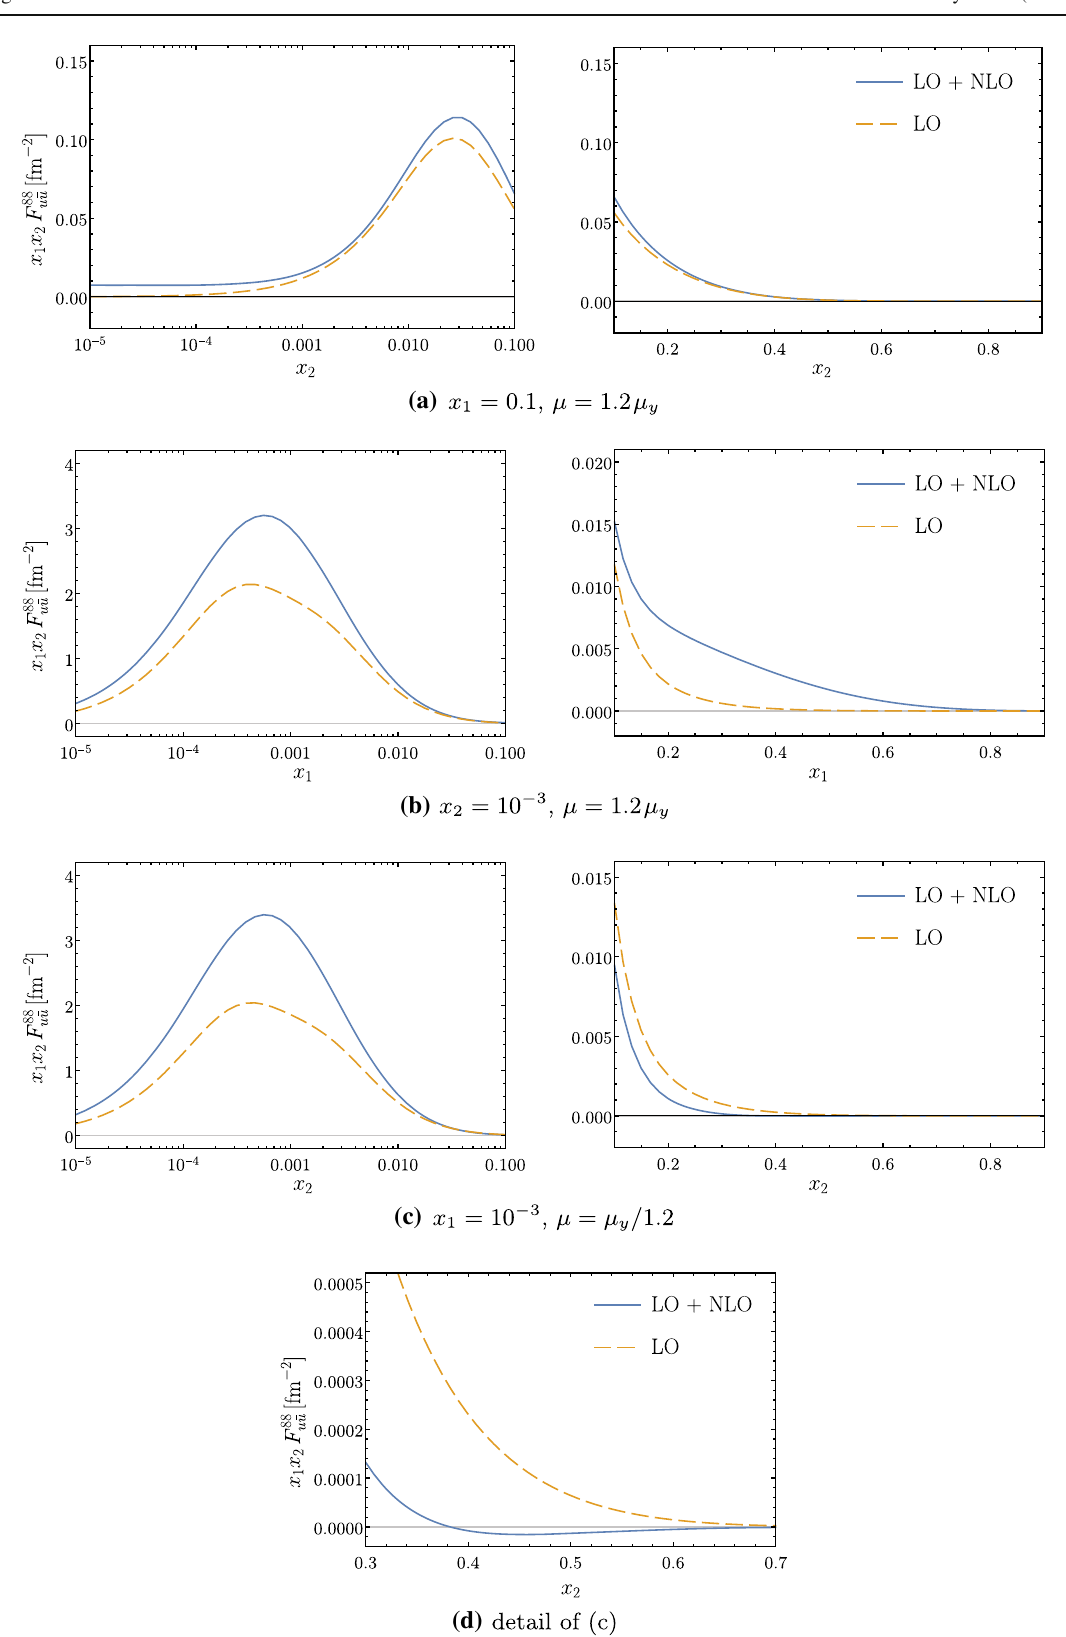
Fig. 13 Continuation of Fig. 12. Notice that x 1 is fixed in panels a , c , and d , whilst x 2 is fixed in panel